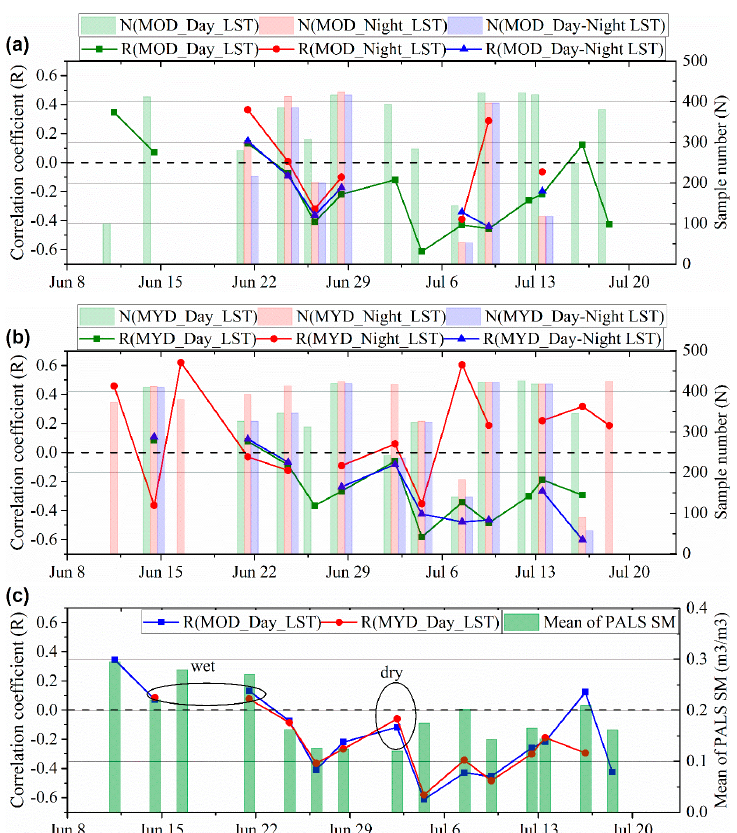
Figure 7. Spatial correlations of PALS soil moisture with day, night, and day-night differential LST from ( a ) Terra MODIS and ( b ) Aqua MODIS. Daytime LSTs from Terra and Aqua MODIS are compared specially in subgraph ( c ). MOD and MYD represent the MODIS sensors on Terra and Aqua satellites, respectively. Here, R(*) represent Pearson correlation coefficient between * and SM. N(*) represents the number of comparison samples between * and SM.